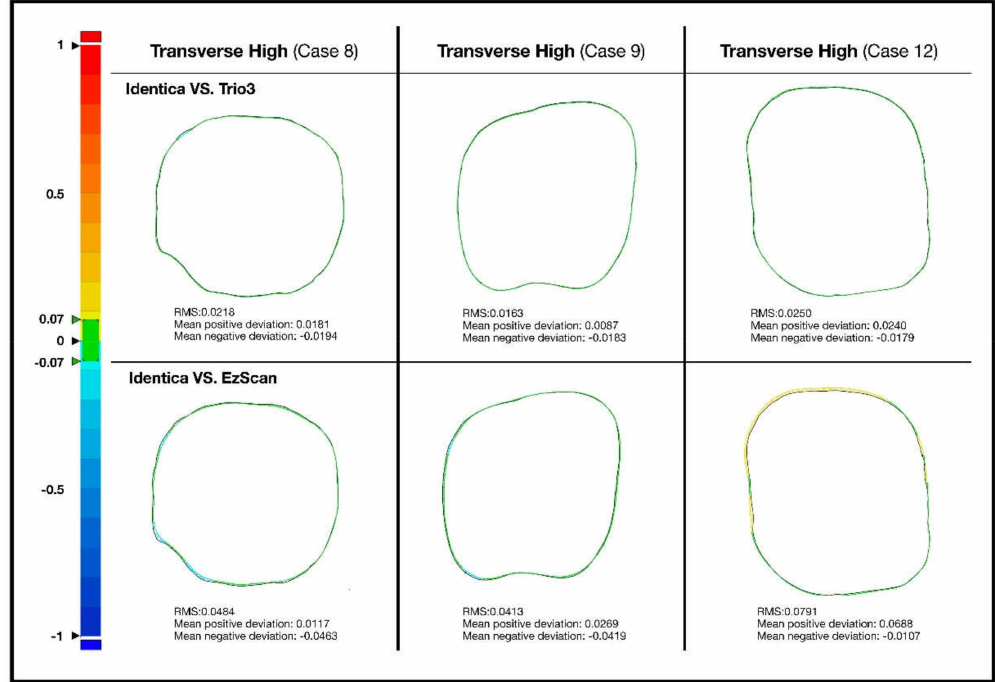
Figure 4. Comparison of transverse high section, transverse middle, and transverse low section in extracted study cases with pronounced error. Table 1. Results of 2-dimensional analysis for two intraoral scanners (Trios 3 ® , EzScan ® ) vs. Identica ® at 5 cross sections (BL, MD, TH, TM, TL) expressed with RMS, mean positive deviation, and mean negative deviation values. Asterisk indicates statistical significance ( p <